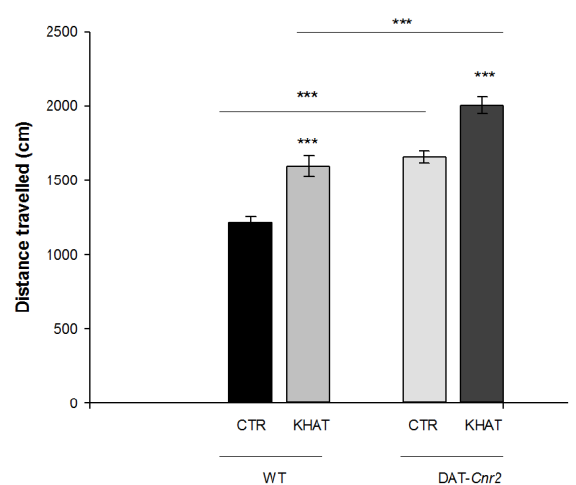
Figure 1. Sub-acute effect of khat extract on distance travelled (centimeters) in the activity monitor apparatus in wild type (WT) and DAT- Cnr2 mice. Values are mean ± SEM (n = 6 in each group). Statistical analysis was done using student t -test. *** p < 0.001. CTR (control group received the vehicle), KHAT (treatment group received khat extract in a dose of 300 mg/kg). The vehicle and khat extract were administered to mice once daily for seven consecutive days.